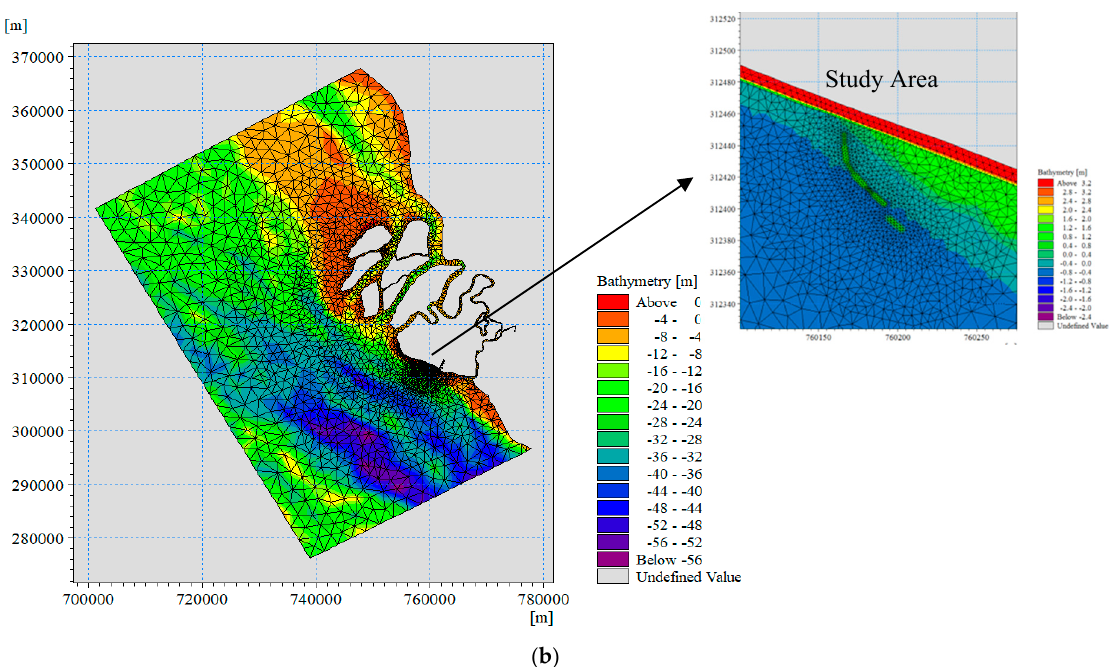
Figure 6. Computational domain: ( a ) hydrodynamic and wave models; ( b ) mud transport model.